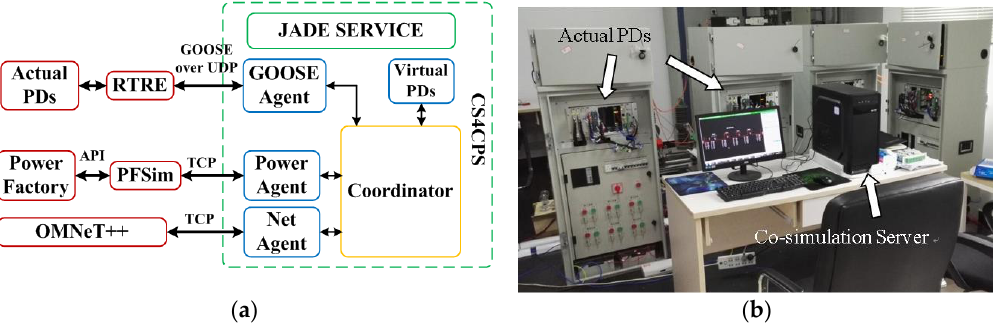
Figure 7. The co-simulation test system ( a ) architecture and ( b ) simulation server and PDs.